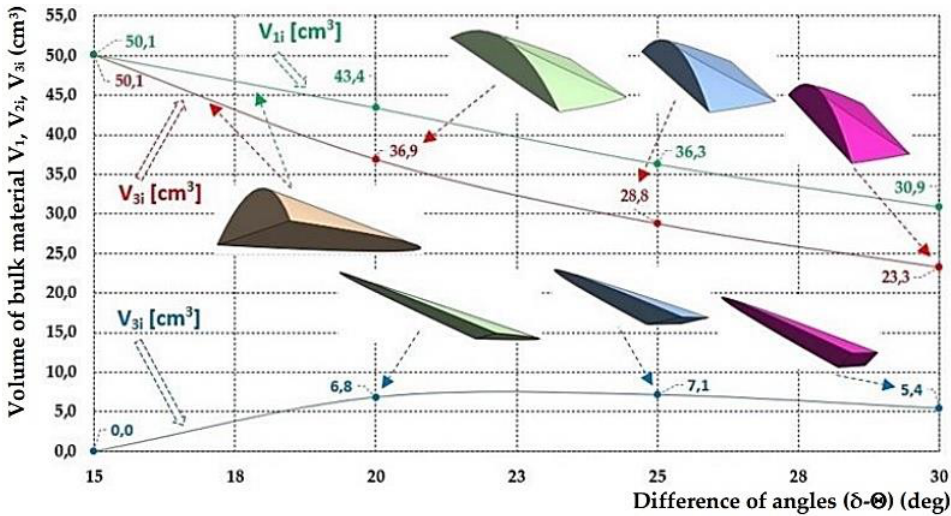
Figure 8. Volume of material remaining on the conveyor belt and spilling over the belt cleat of a height of H 1 = 15 mm. Table 4. Volume of material V i(δ–Θ) [cm 3 ] for H 1 = 20 mm belt cleat.